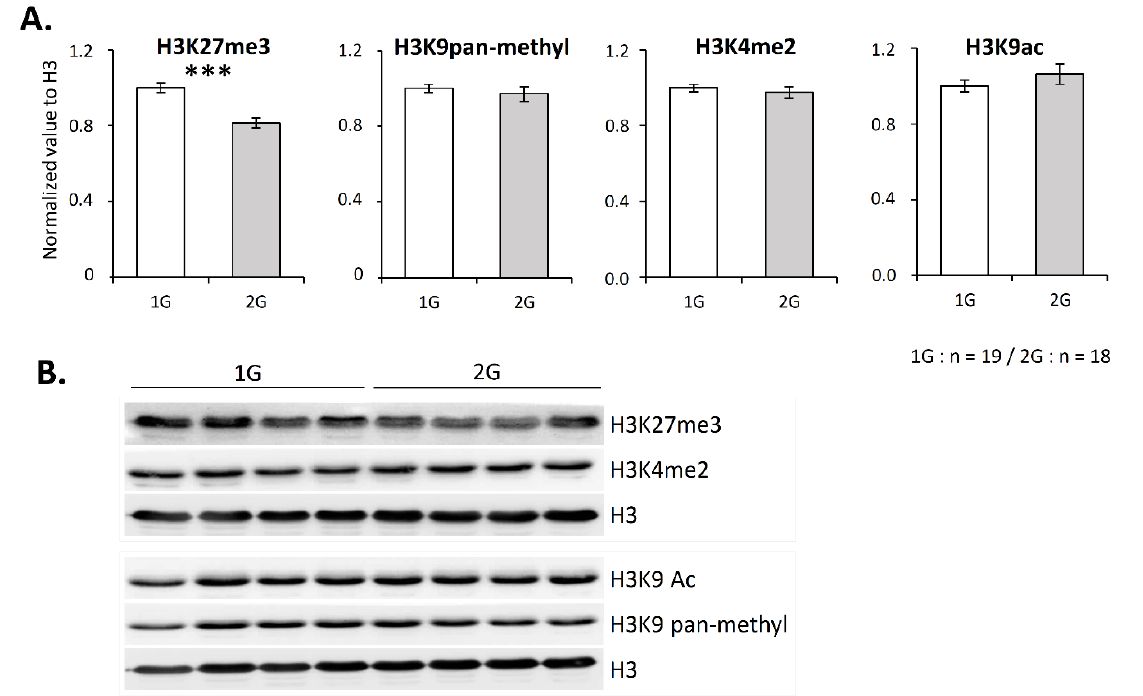
Figure 3. H3K27 trimethylation level is reduced in the thymus after 3 weeks spent at 2G. ( A , B ) H3 lysine 27 trimethylation, global H3 lysine 9 monomethylation, dimethylation or trimethylation (named panmethylation), H3 lysine 4 di-methylation and H3 lysine 9 acetylation evaluated by Western blotting. ( A ) H3-corresponding lysine methylation or acetylation relative expression normalized to H3. ( B ) Representative Western blots obtained with four mice in each group. Data are mean ± SEM of 19 or 18 mice per group. Mann–Whitney or t -tests were used to reveal statistically significant differences. *** p < 0.001.